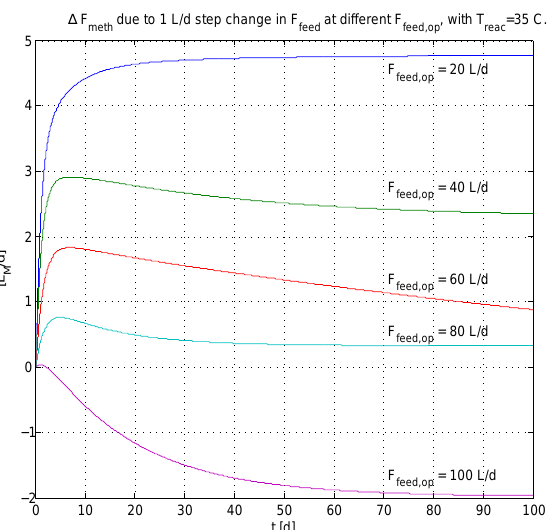
Figure 14: Simulated ∆ F meth ( t ) for a number of differ- ent values of F feed due to a step change op of amplitude 1 L/d of F feed from F feed . op T reac = 35 o